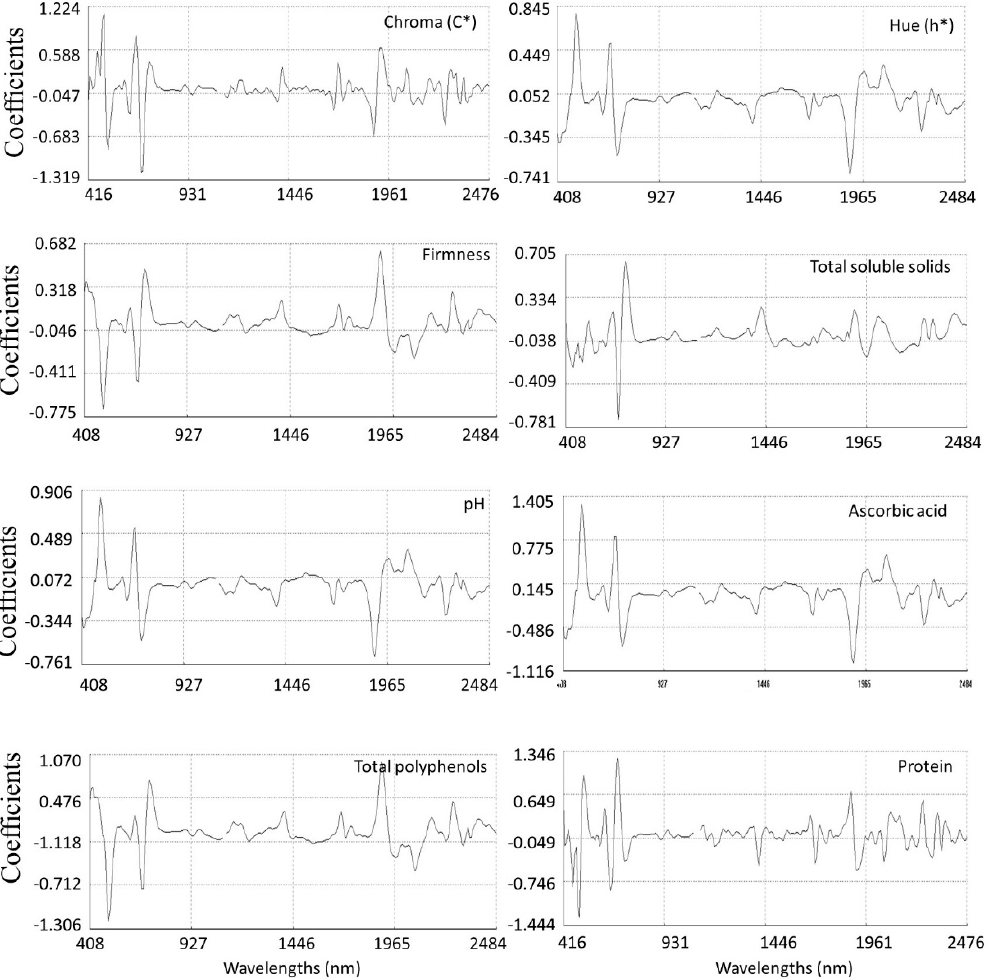
Figure 8. Modified partial least squares (MPLS) loading of the optimal calibrations for physicochemical compounds measured by NIRS.